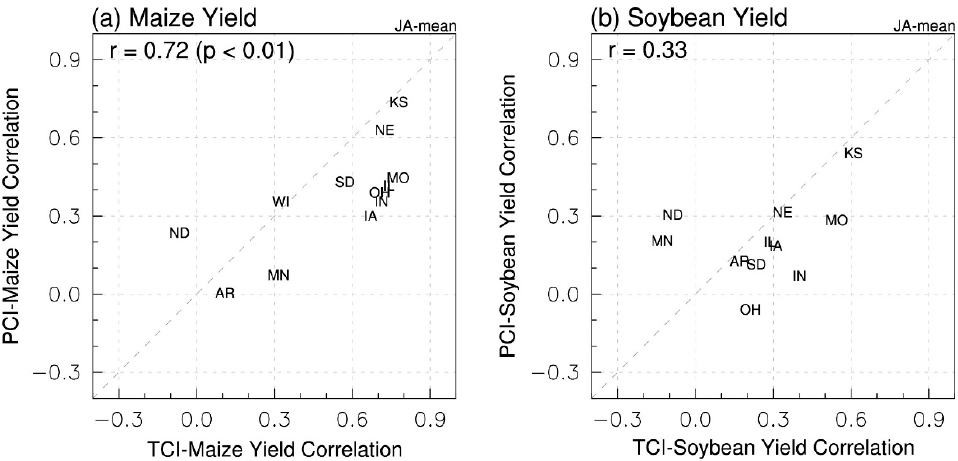
Figure 7. Scatter plot of TCI–crop yield relationship ( x -axis) and PCI–crop yield relationship ( y -axis) at the state-level data from ( a ) maize and ( b ) soybean, respectively, averaged for July and August. In Figure 7b, the correlation for Wisconsin is omitted due to the lack of data.